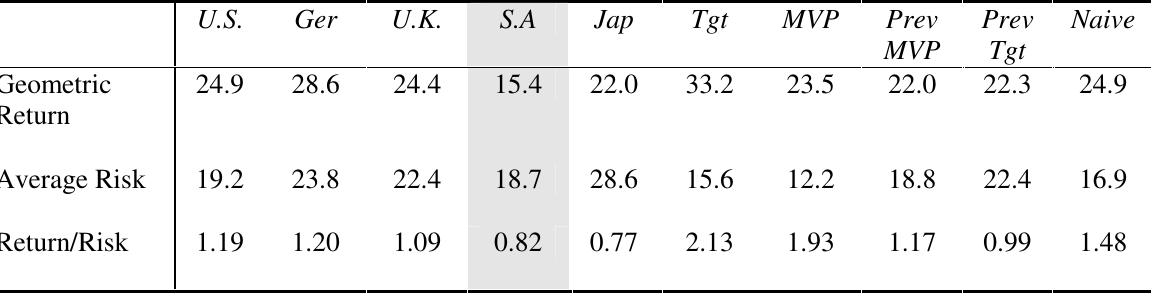
Table 11. Risk-adjusted portfolio performance